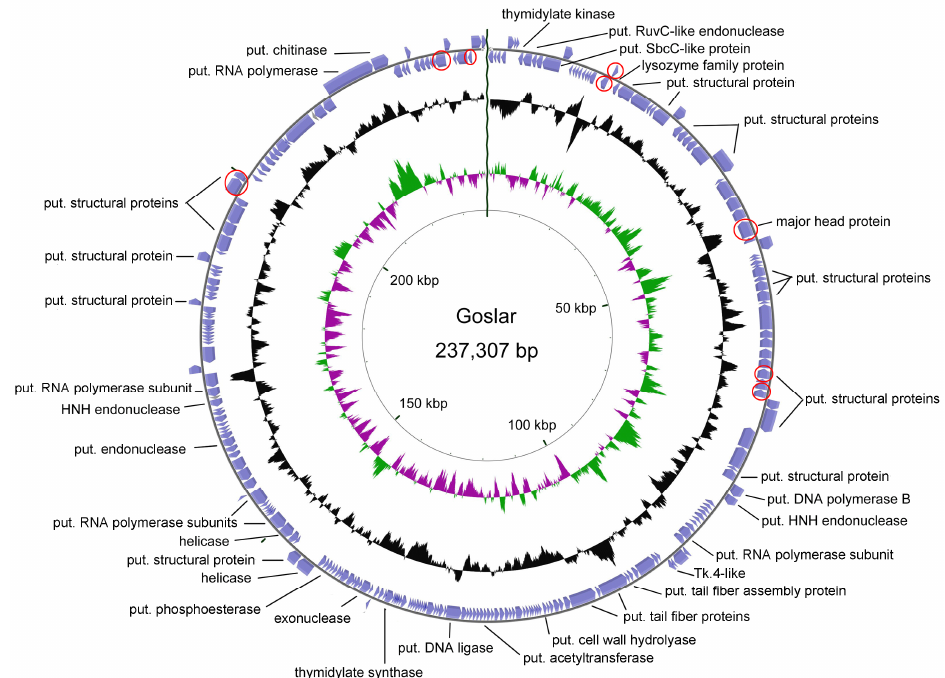
Figure 10. Genomic organization of phage Goslar. Based on its permutation, the genome is visualized in a circular form. Genes for identified structural proteins using peptide mass fingerprinting are marked in red (put. =